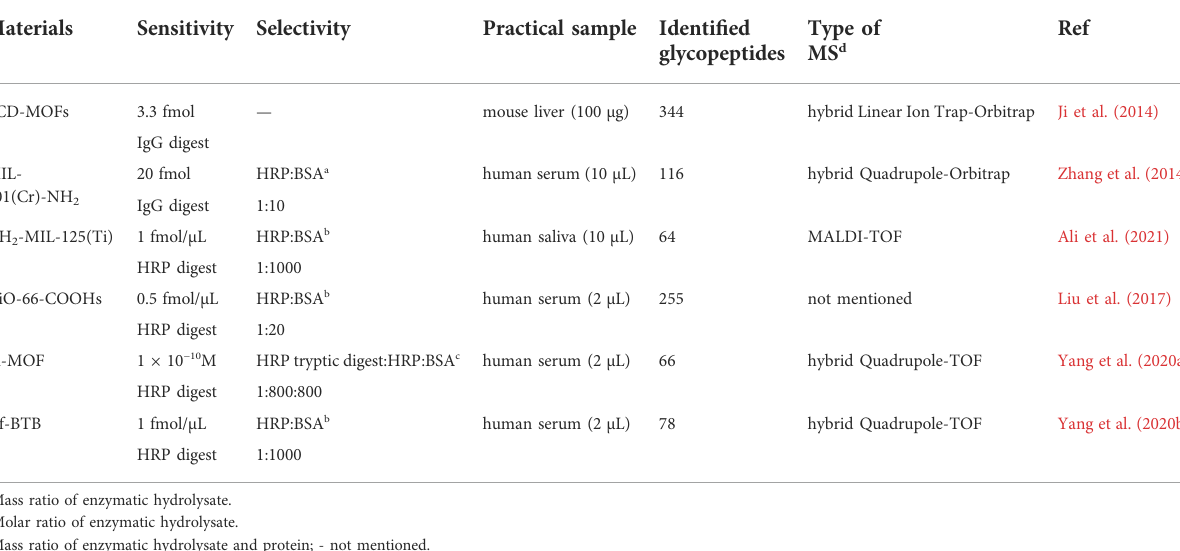
Figure 3B con fi rmed the uniform and well-de fi ned hollow morphology. Besides, contact angle measures (Figure 3C) suggested the exhibited exceptional hydrophilicity of HHZr- MOFs (~9.2 ° ), which was much lower than those of Zr-MOFs